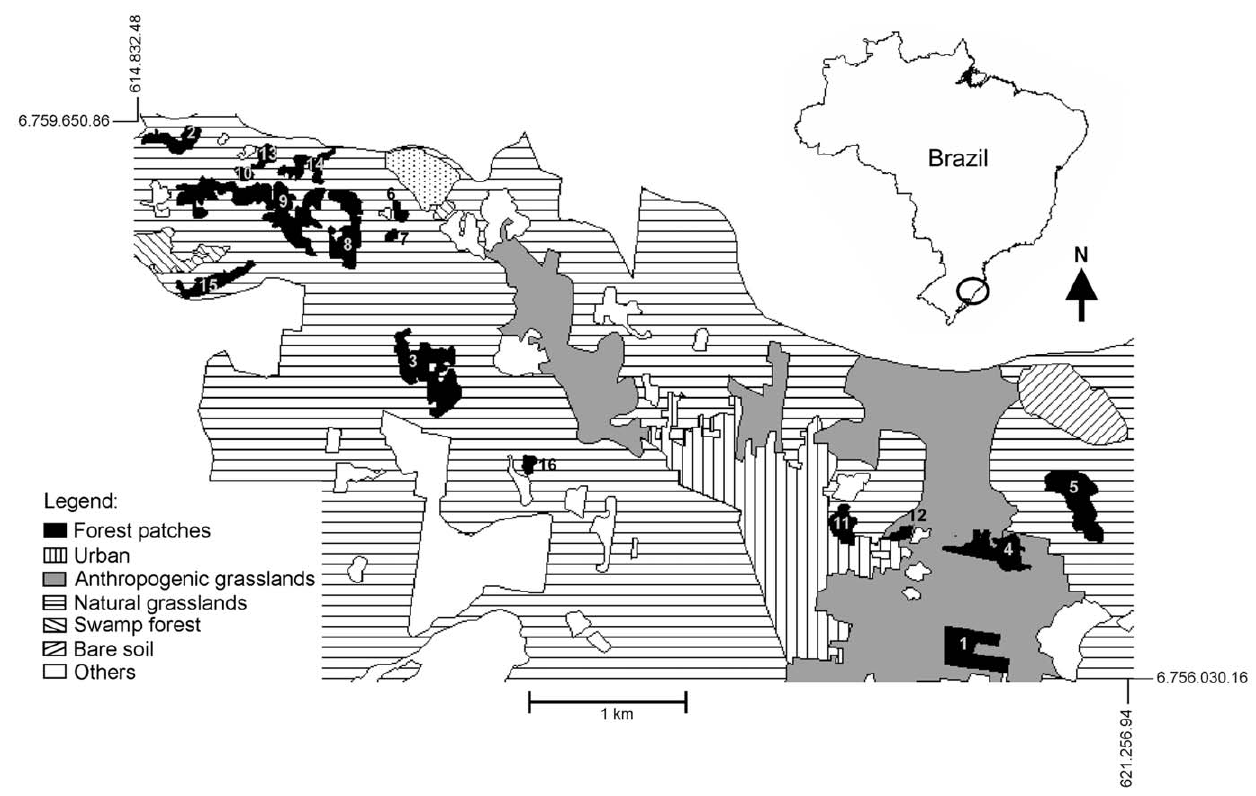
Figure 1. Land-use map of the landscape mosaic. Map showing the 16 forest fragments of Atlantic Forest and the fragment surroundings. Coordinates are in UTM system (22 J).